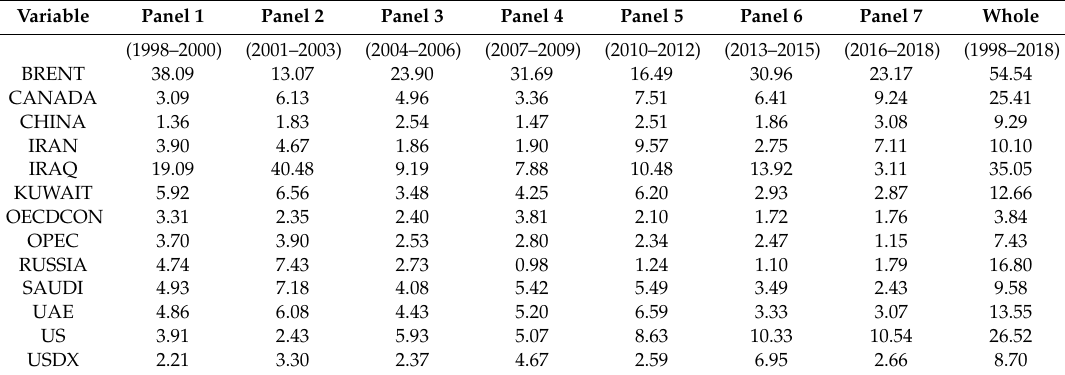
Table 3. Coe ffi cients of variations for each of variables by